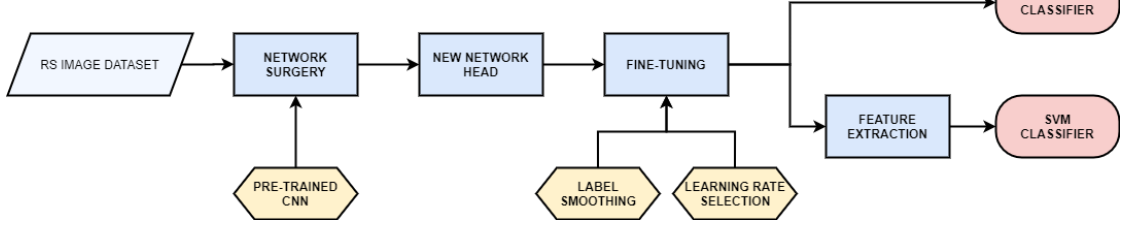
Figure 1. Flowchart of the proposed